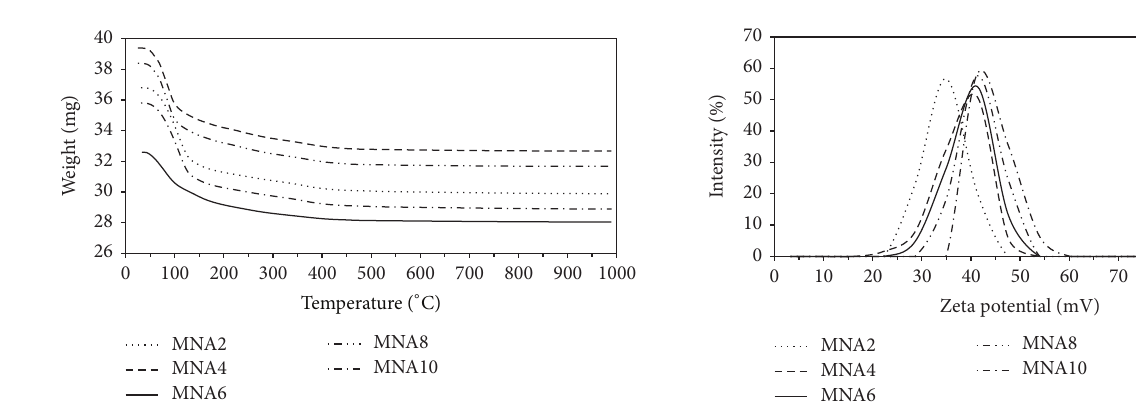
Figure 7: Zeta potential of all